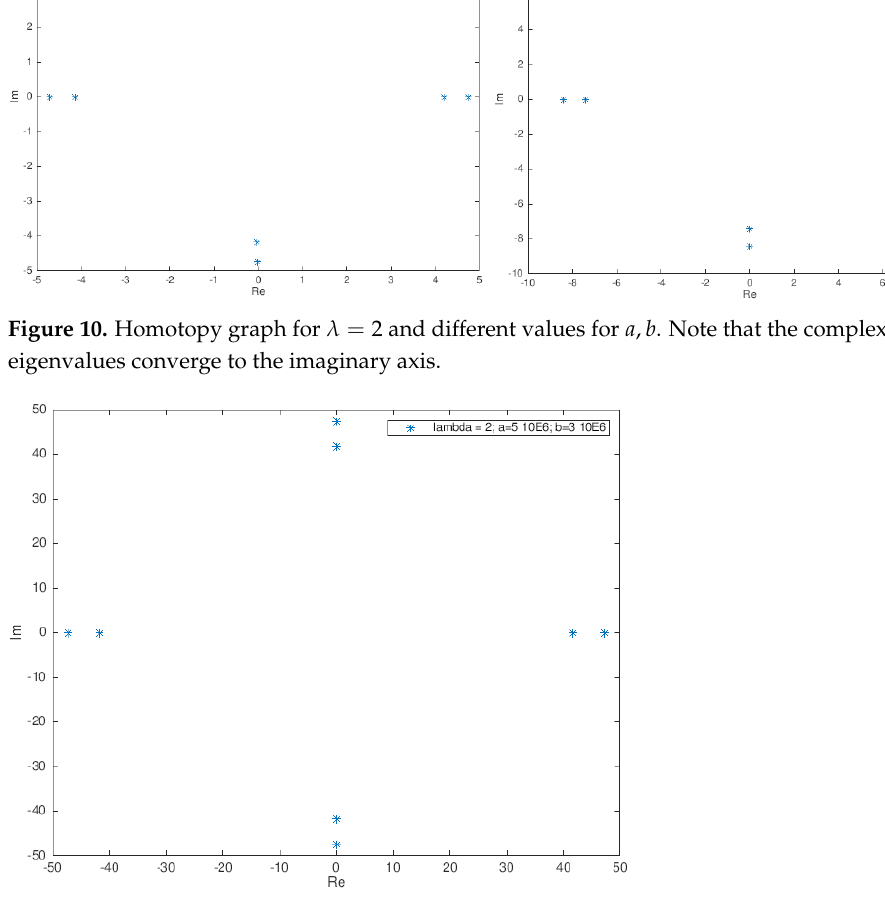
Figure 11. Homotopy graph for λ = 2 and different values for a , b . Note that the complex conjugate eigenvalues converge to the imaginary